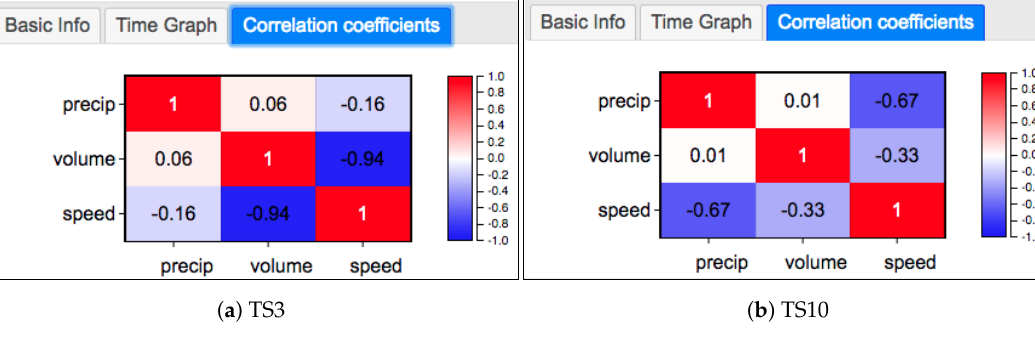
Figure 11. Correlation coefficient matrices in January 2017.